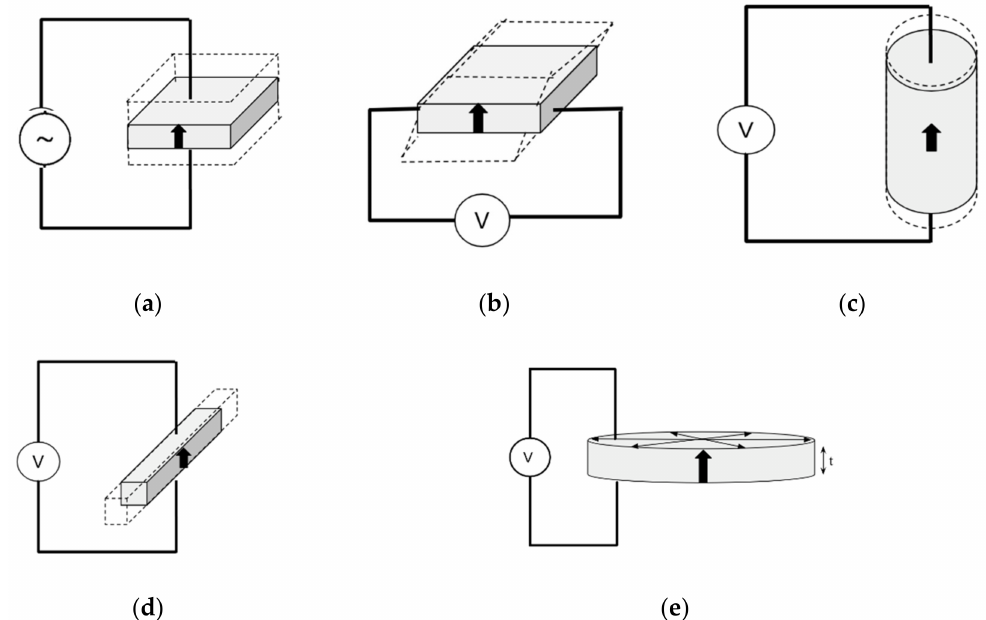
Figure 2. Schematic of the resonant modes of vibration of ceramic resonators: ( a ) Thickness extensional of a thickness poled thin plate; ( b ) Shear of a non-standard thickness poled thin plate; ( c ) Length extensional of a longitudinally poled cylinder or bar; ( d ) Length extensional of a thickness poled thin bar; ( e ) Radial extensional of a thickness poled thin